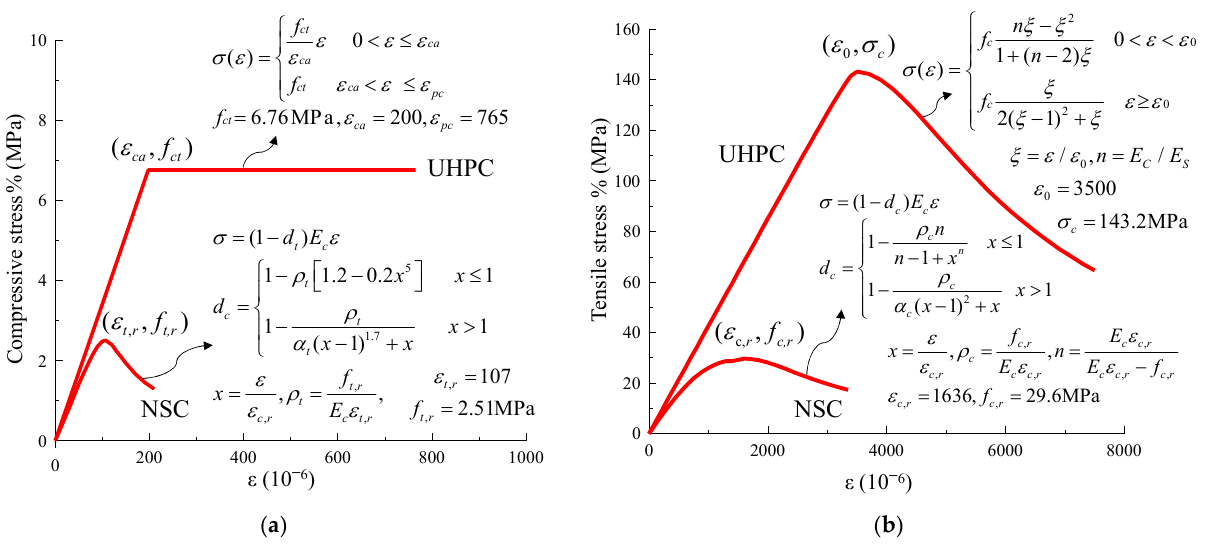
Figure 9. Uniaxial stress–strain relationships of UHPFRC and NSC: ( a ) Tension [25,31]; ( b ) compres- sion [25,32].